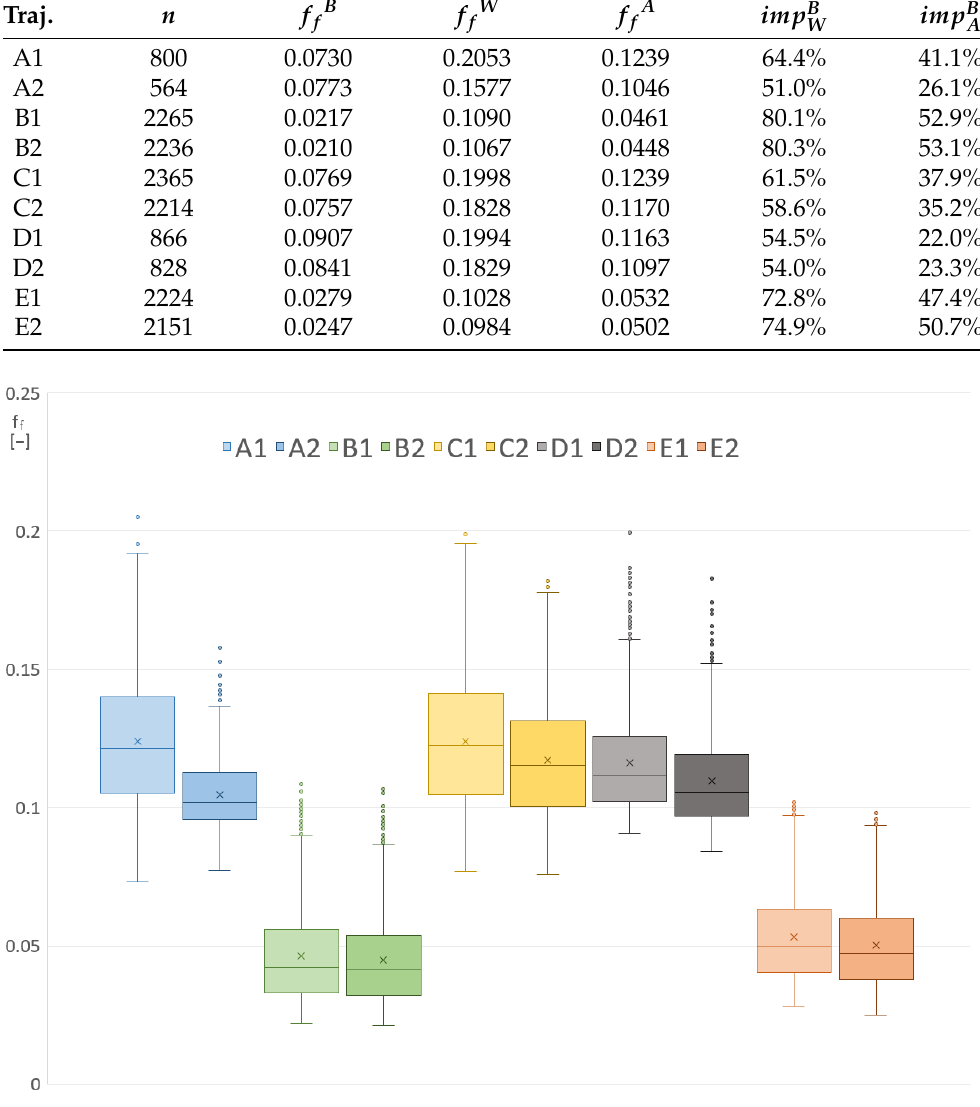
Table 2. Results for the 10 testing trajectories showing the number of valid robot locations n , the fitness function value in the best location f f B , in the worst location f fW , the average value f f A ; and improvement of the best location against the worst imp B Traj.